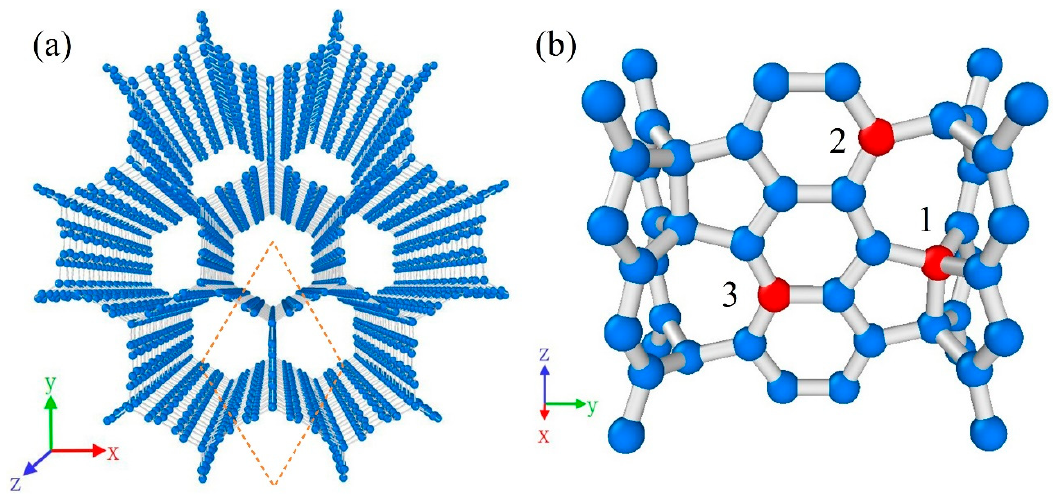
Figure 1. Snapshots of carbon honeycomb. ( a ) Perspective view of atomic structure of CHC; ( b ) Atomic structure on the junction. Red atoms represent three kind of vacancy defects of CHC.